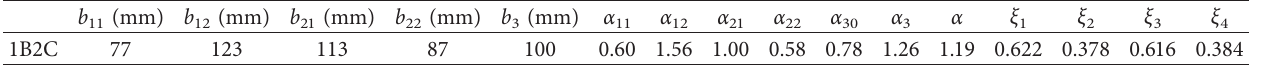
Figure 8: Sensitive analysis of the number of finite elements. (a) Measure points in top flanges of midspan cross section. (b) Measure points in bottom flanges of midspan cross section. Table 1: Parameters for shear lag effect analysis in the thin-walled single-box two-cell box girder.